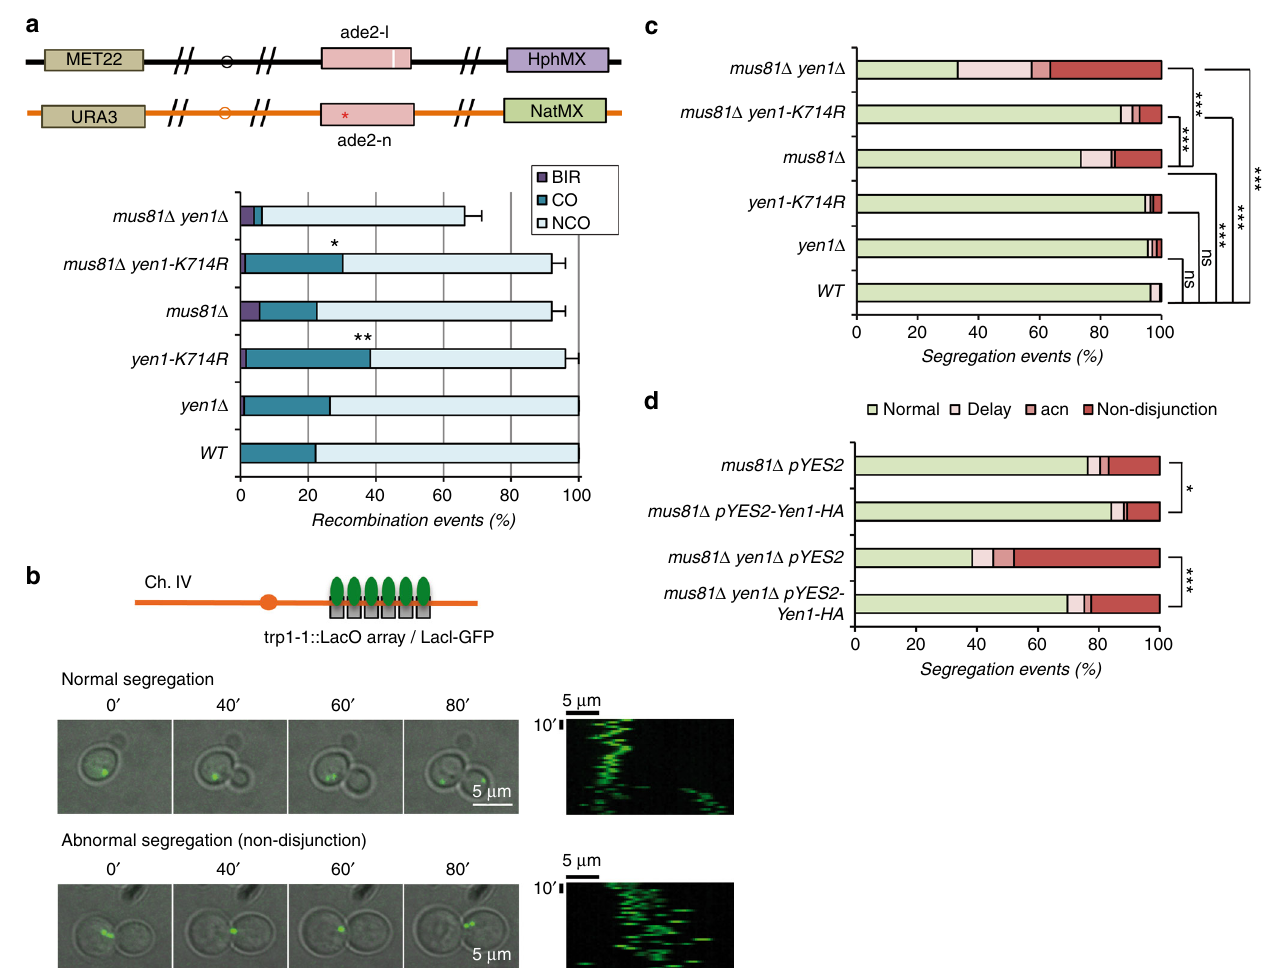
Fig. 7 Yen1-K714R increases COs and suppresses spontaneous chromosome segregation defects in mus81 Δ cells. a Diagram explaining the Chr. XV DSB- induced crossover reporters. Recombination outcomes were scored in white/red sectored colonies of the indicated strains and normalized to its plating ef fi ciency (PE). The number of independent experiment trials (T) and the total number of recombination events scored ( n ) were as follows: WT ( T = 6, n